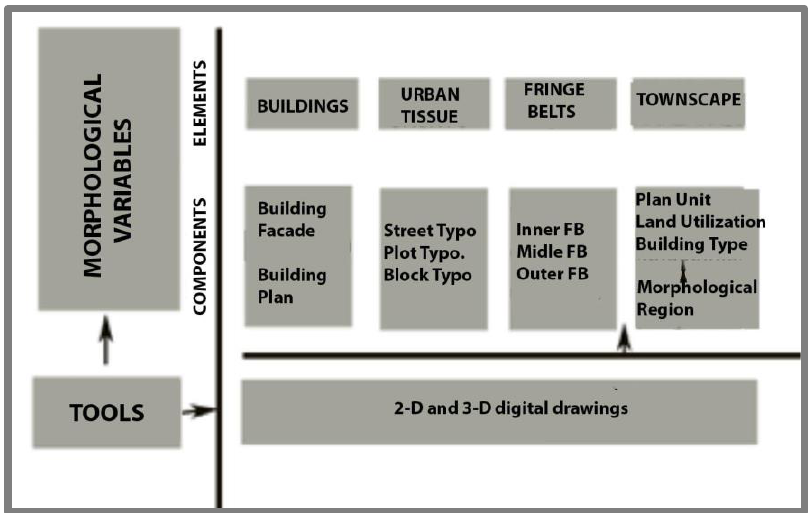
Table 1 Framework of integrated methodology (Cömert & Hoşkara,